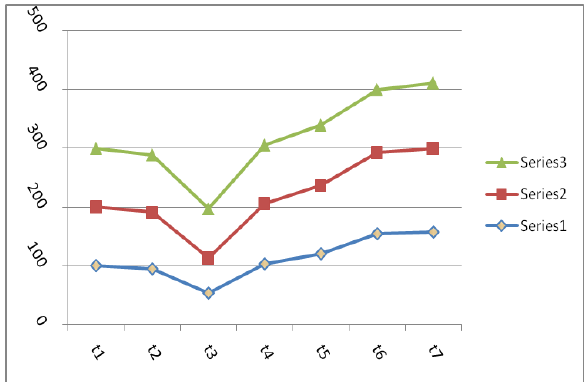
Figure 1. PRE of estimators for Population-1